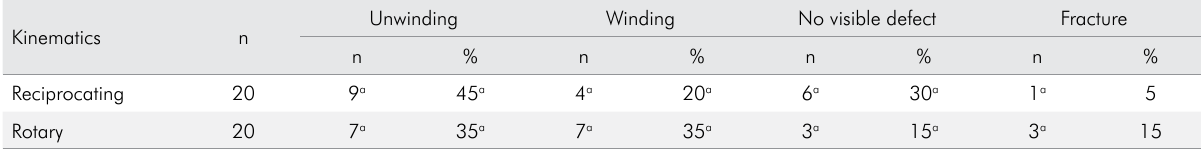
Table 2. Types of defects identified, and number and percentage of fractured instruments after simulated clinical use of different kinematics. Kinematics